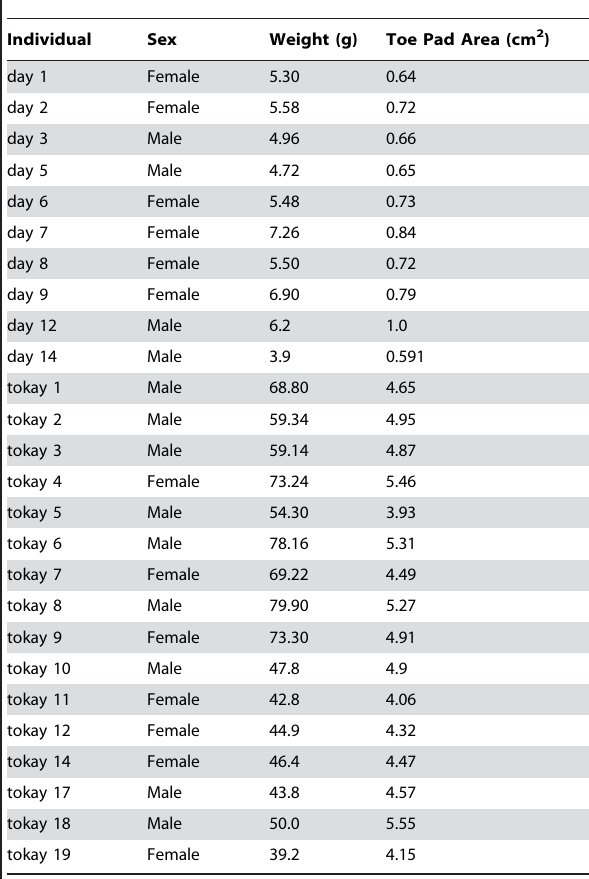
Table 1. Sex, size, and toe pad area of geckos used in experimental trials. Toe pad area is an estimate of maximal area of scansors visible on